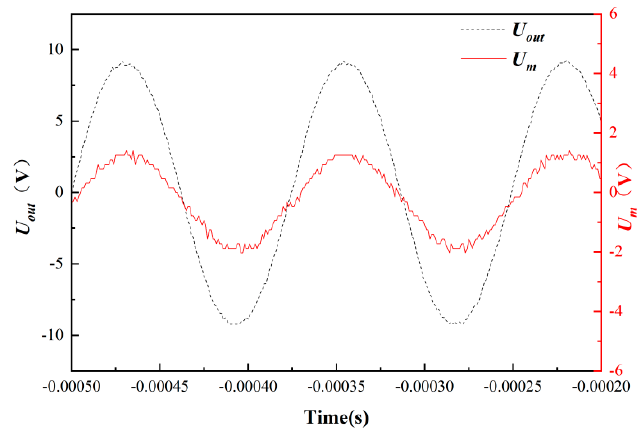
Figure 3. DBD plasma reactor electrical parameter curve.